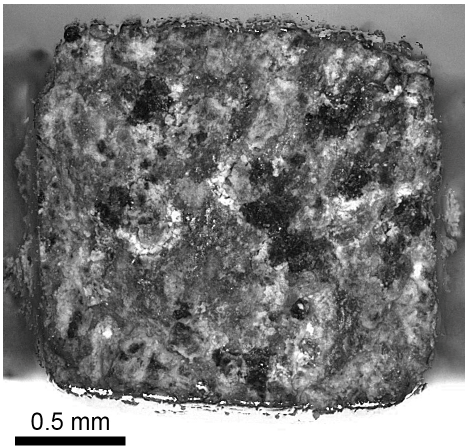
Figure 6. Laser confocal image microscopy image showing typical fracture surface morphology appearance after corrosion fatigue of the two-step MIF-processed ZK60 alloy tested at Δσ /2 = 50 MPa.